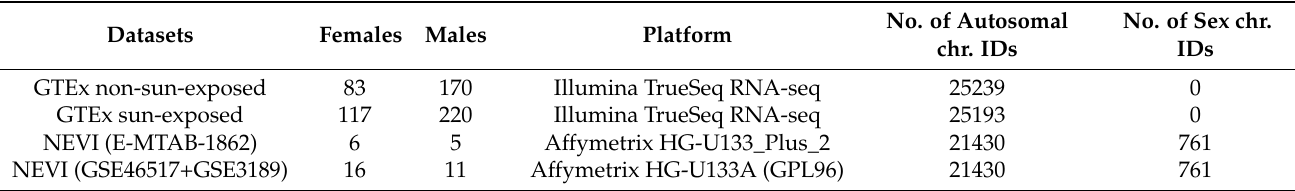
Table 2. Detailed characteristics of the analyzed non-melanoma